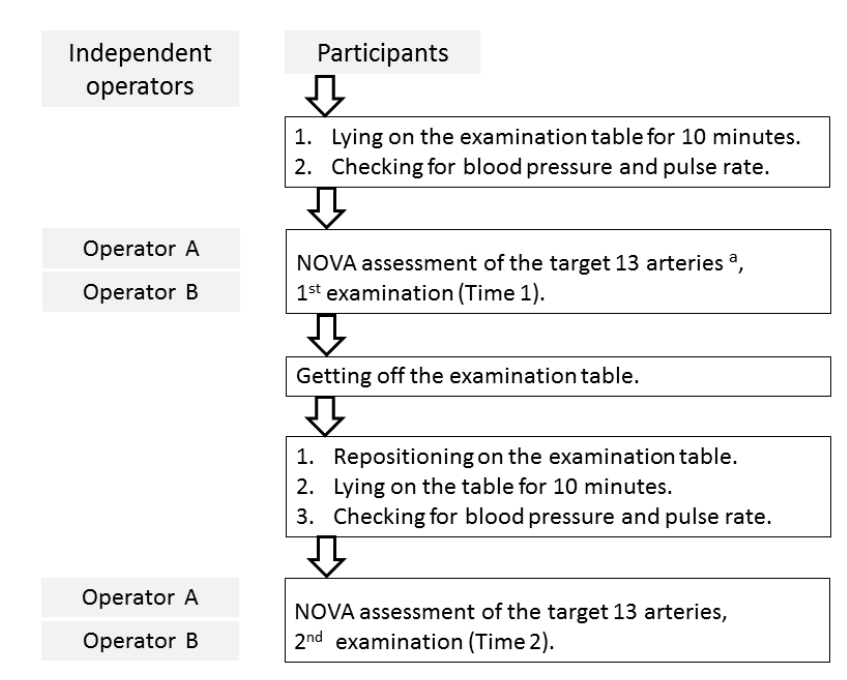
Figure 1. Summary of study procedures. NOVA, non-invasive optimal vessel analysis. a Target vessels included basilar artery, bilateral vertebral arteries, bilateral posterior cerebral arteries, bilateral middle cerebral arteries, proximal and distal segments of bilateral anterior cerebral arteries, and bilateral internal carotid arteries.